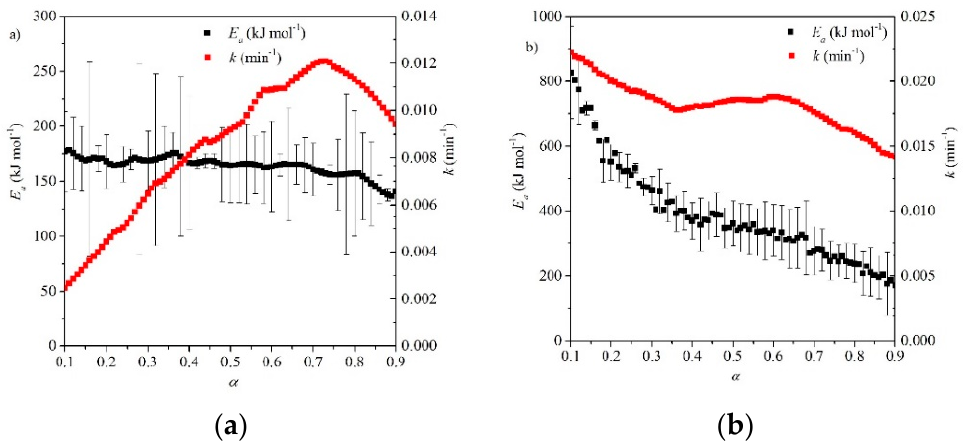
Figure 11. Isoconversional values of E α for CaCO 3 calcination: ( a ) under N 2 ; ( b ) under CO 2 . [46].